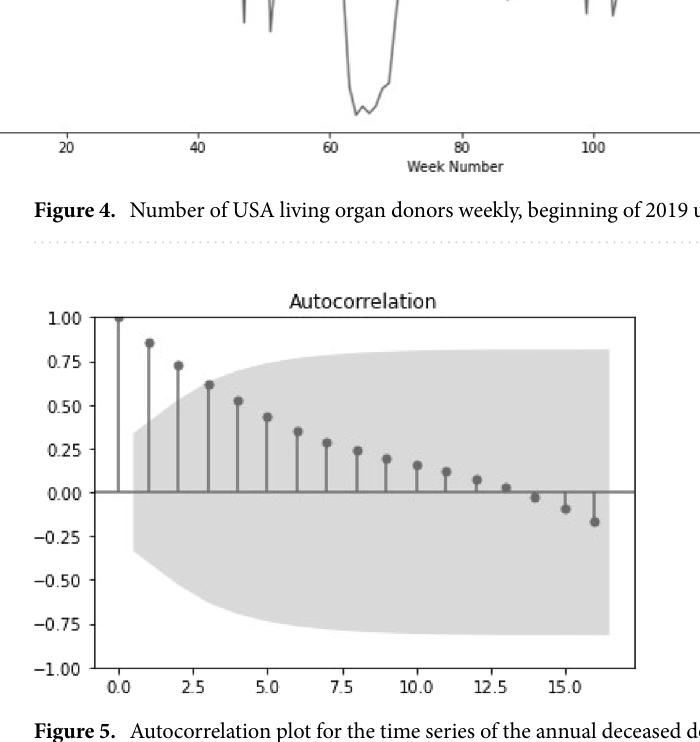
Figure 5. Autocorrelation plot for the time series of the annual deceased